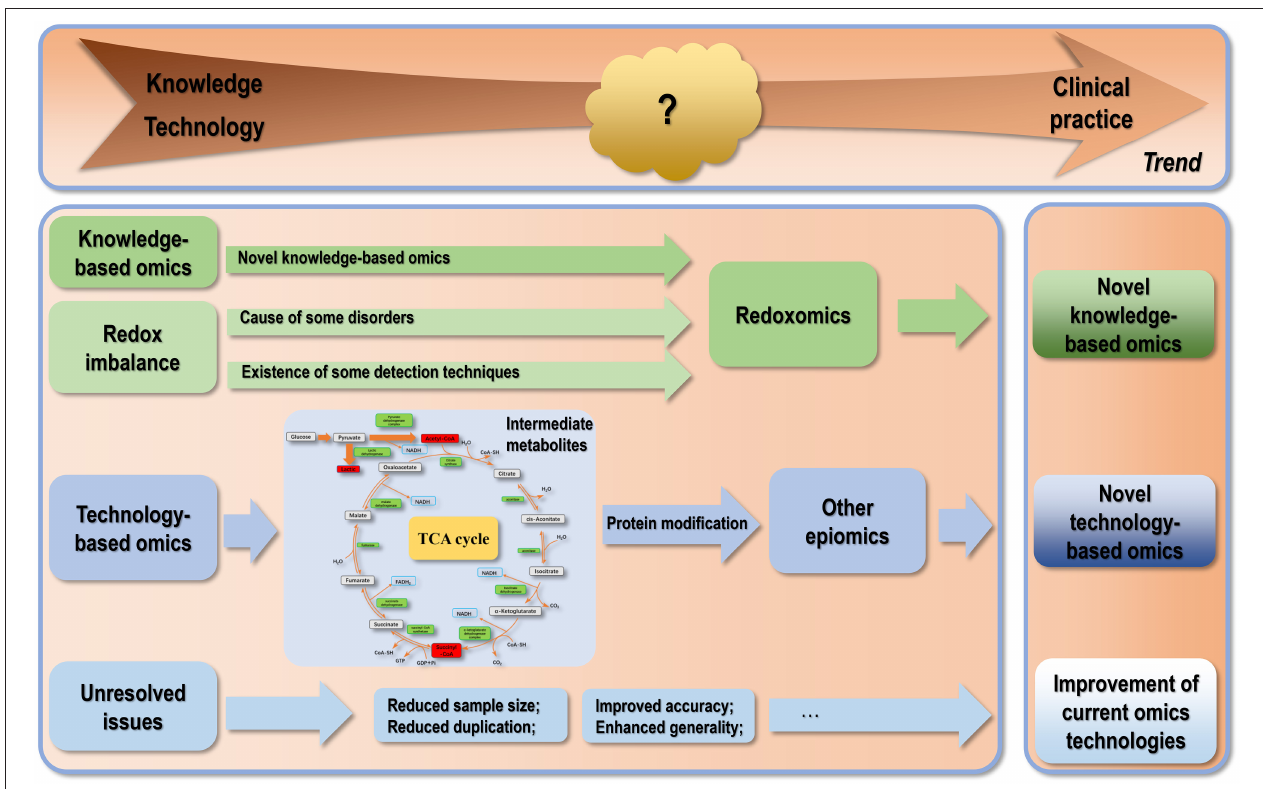
FIGURE 2 | Conceptual illustration on the future trend in omics technology development. There are three trends regarding the developmental paths of omics technologies. The first category of tasks is to resolve the technical problems existing in current omics techniques. The second trend is the identification of novel types of omics especially novel epiomics derived from modifications by various intermediate metabolites. With increased understanding on the importance of cell homeostasis at various levels regarding human disease management, there is a trend of cutting into a particular knowledge domain from a systematic angle via omics data integration as demonstrated by immunomics and microbiomics. In this trend, we propose “redoxomics” as an emerging type of knowledge-based omics given the critical roles of redox homeostasis in maintaining cells at the healthy state and the pathogenesis of various diseases including